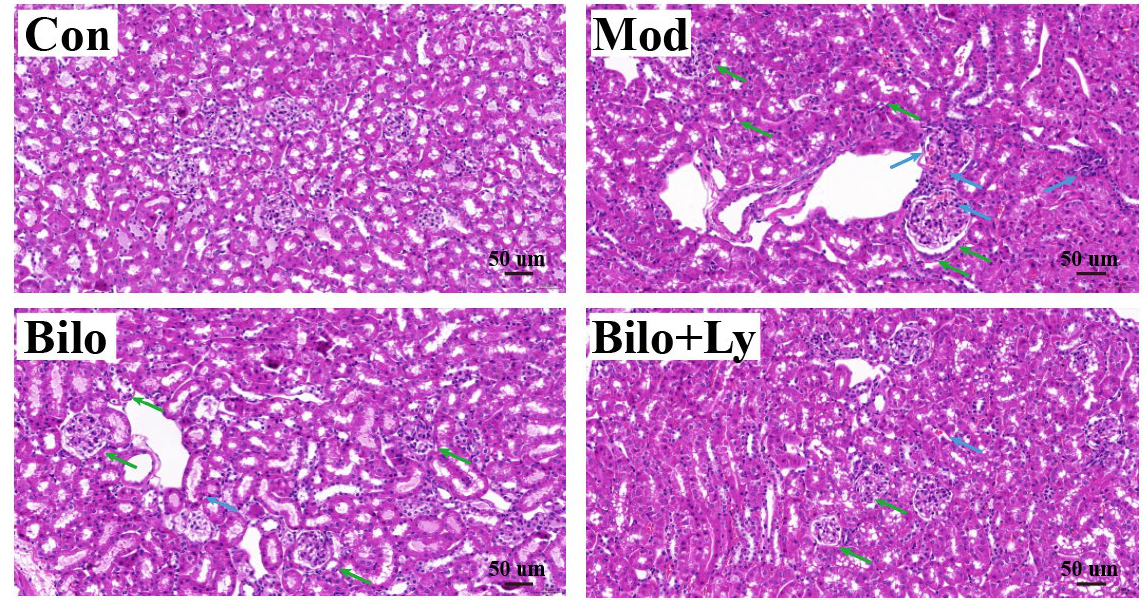
Figure 2. The effect of lycopene on the histopathology of mouse kidney. Histopathology of hema- toxylin and eosin staining (200×) of kidney sections from different groups (Con, Mod, Bilo, and Bilo+Ly). Glomerular atrophy is impaired (green arrows), and tubules and blood vessels are dilated (blue arrows).